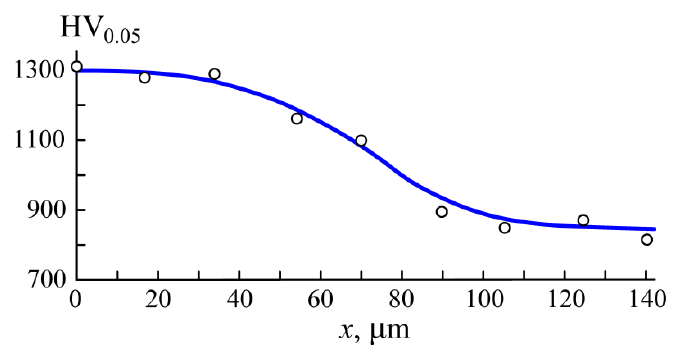
Figure 8. Dependence of the microhardness HV 0.05 on the distance x from the sample surface.